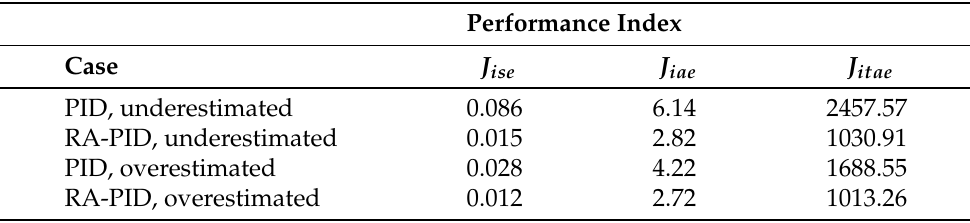
Table 1. Performance indexes for different control methods (RA-PID is a PID controller with adapta- tion turned on; PID is a PID controller without adaptation).